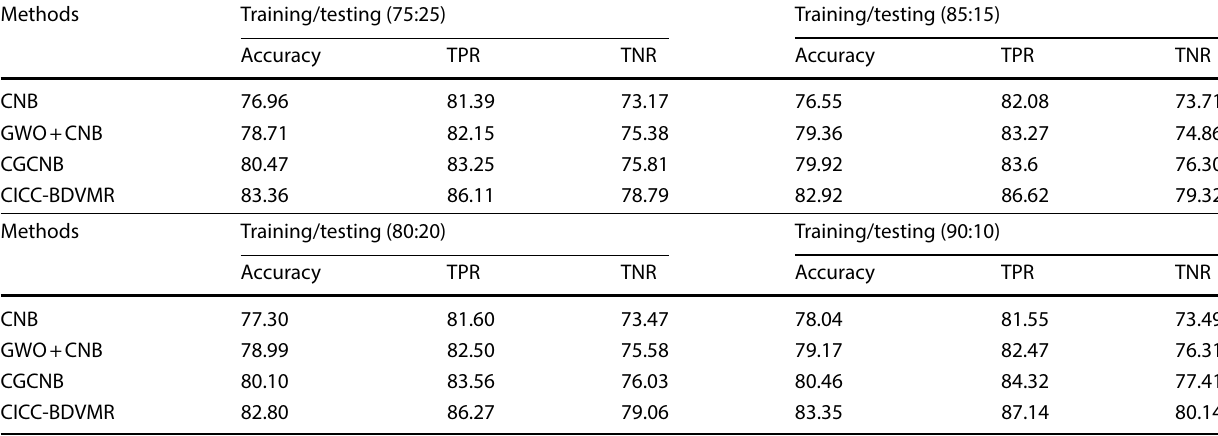
Table 2 Average analysis of CICC-BDVMR technique under distinct sizes of training/testing data in localization data